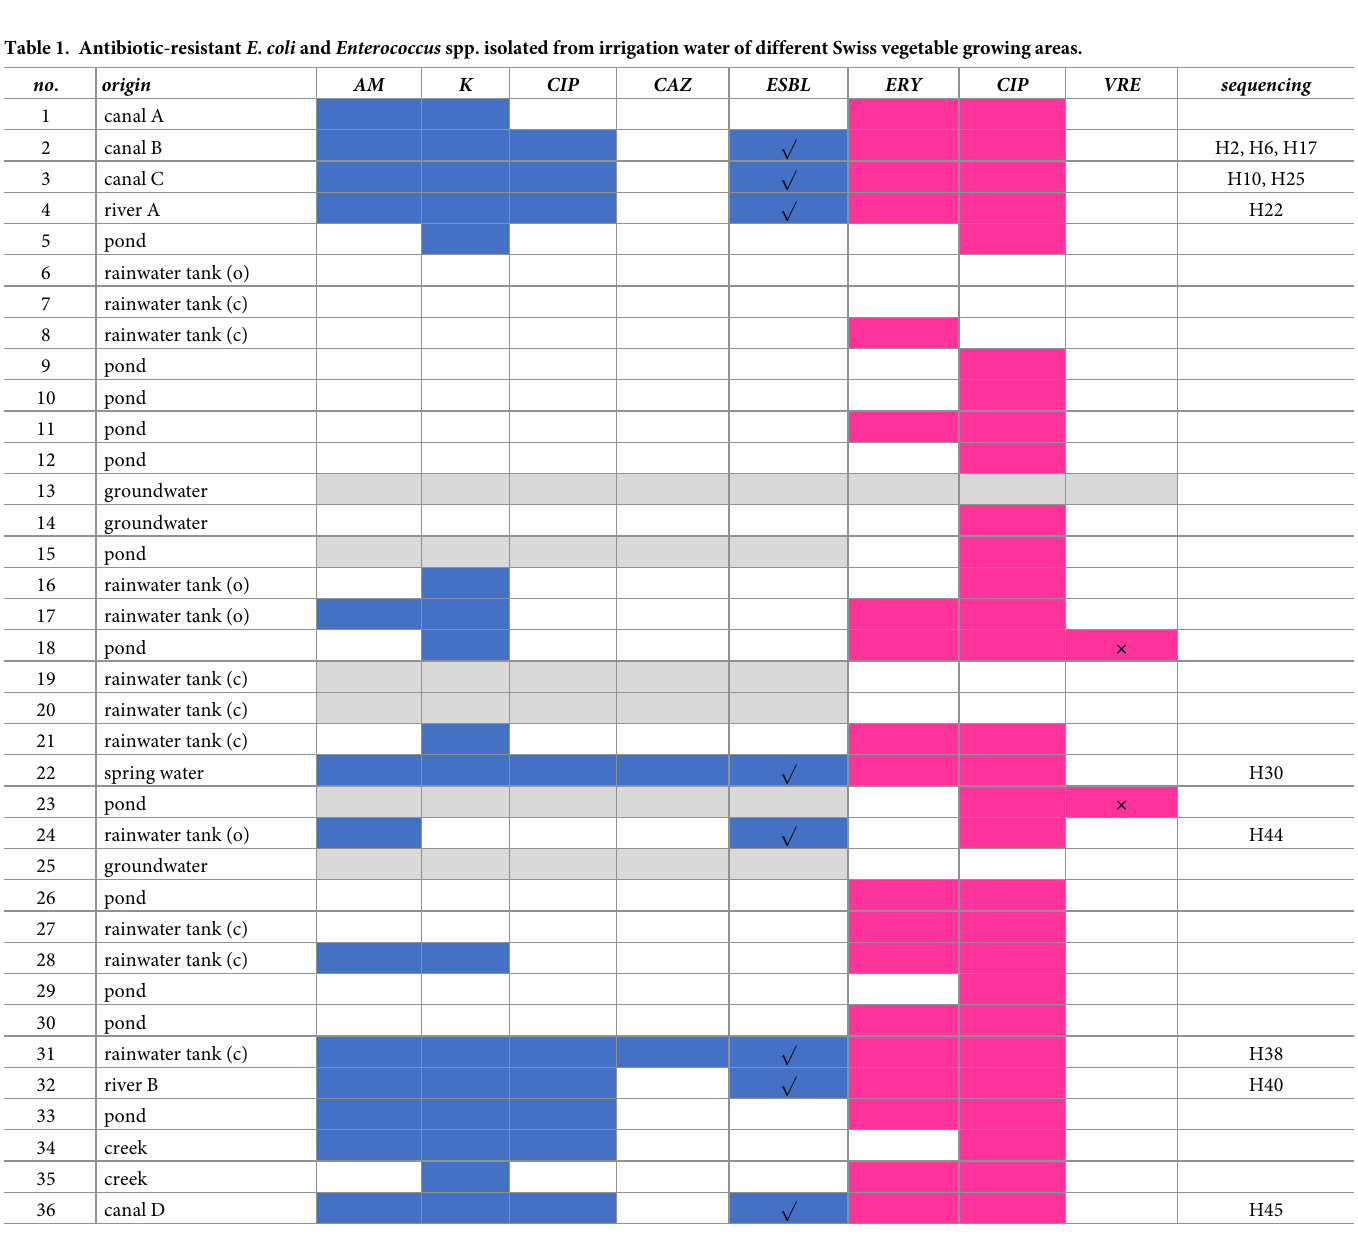
Grey: no generic E . coli or Enterococcus spp. detected on CHROMagar or mEA without antibiotics; white: only generic E . coli or Enterococcus spp. detected; blue: E . coli detected on CHROMagar containing the respective antibiotic or ESBL agar; pink: Enterococcus spp. detected on mEA containing the respective antibiotic or VRE agar. AM: ampicillin; K: kanamycin; CIP: ciprofloxacin; CAZ: ceftazidime; ESBL: commercial ESBL agar; ERY: erythromycin; VRE: commercial VRE agar; (c), closed; (o), p open. : ESBL-producing E . coli confirmed; × : vancomycin-resistant E . faecalis not confirmed. Sequencing: sequenced ESBL-producing E . coli (whole-cell and plasmid